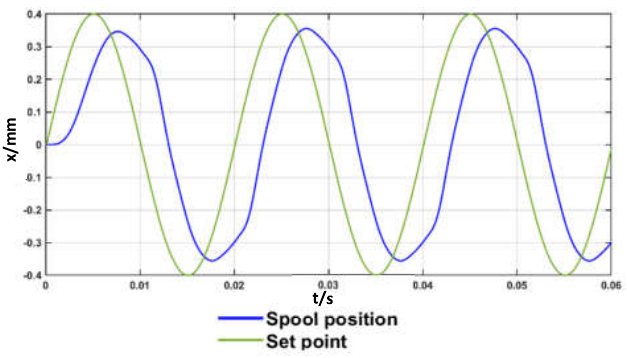
Figure 13. Sine wave response for input amplitude = 0.4 mm and frequency = 50 Hz ( p p − p T = 70 bar, C p = 90 Ns/m, m p = 80 g; ω n , a = 1400 rad/s): spool position vs. time.